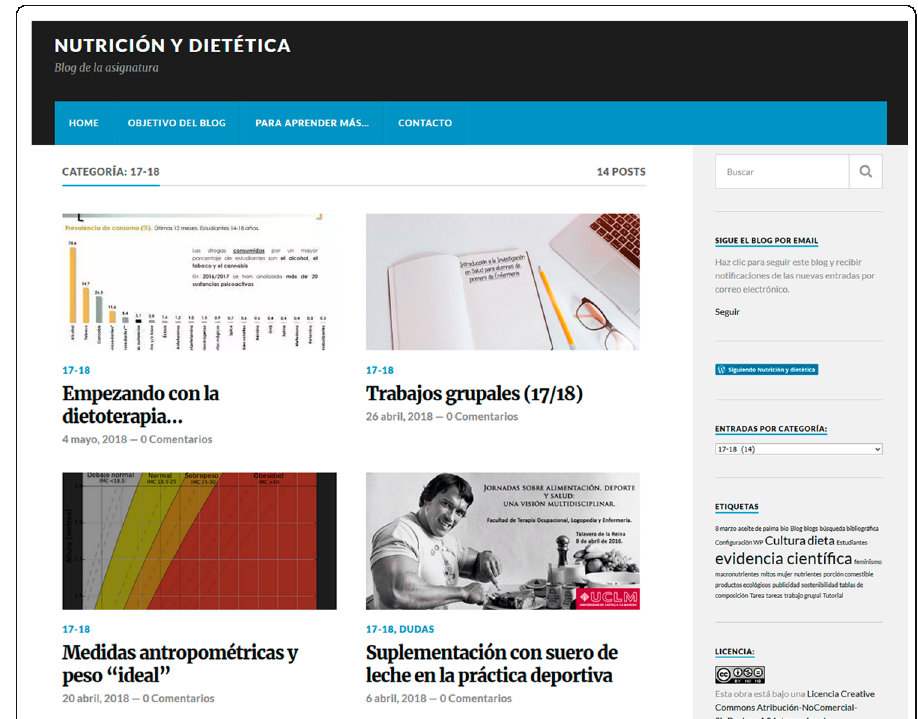
Fig. 2 Snapshot of the Nutrition and Dietetics blog main page. Four pages allow visitors to access all blog content. Information is also organised by means of categories and labels. Blog accessible through